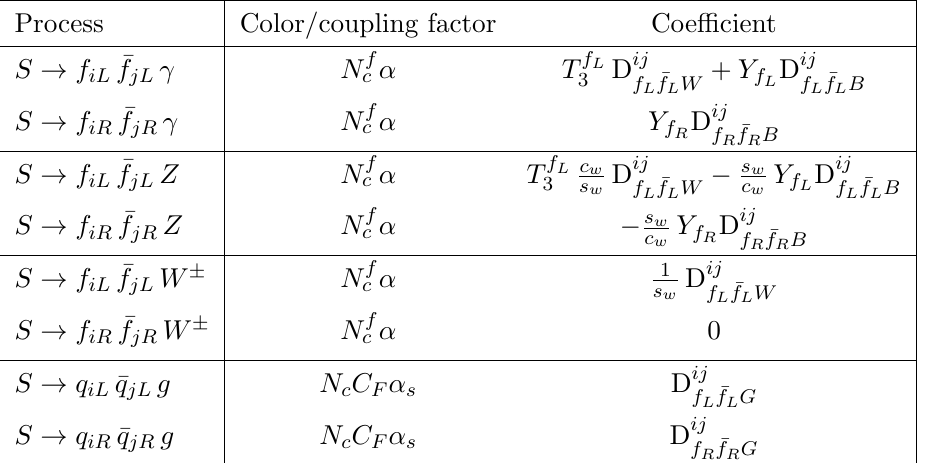
Table 1 . Color factors, gauge couplings and Wilson coe(cid:14)cients entering the expressions for the doubly di(cid:11)erential decay rates for the three-body decays S which are given by a formula analogous to